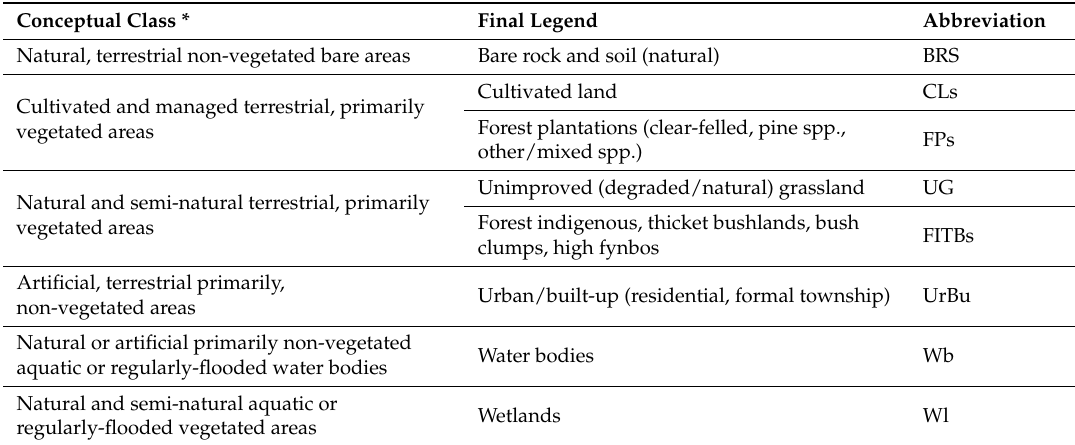
Table 1. Modified LC legend compared to original